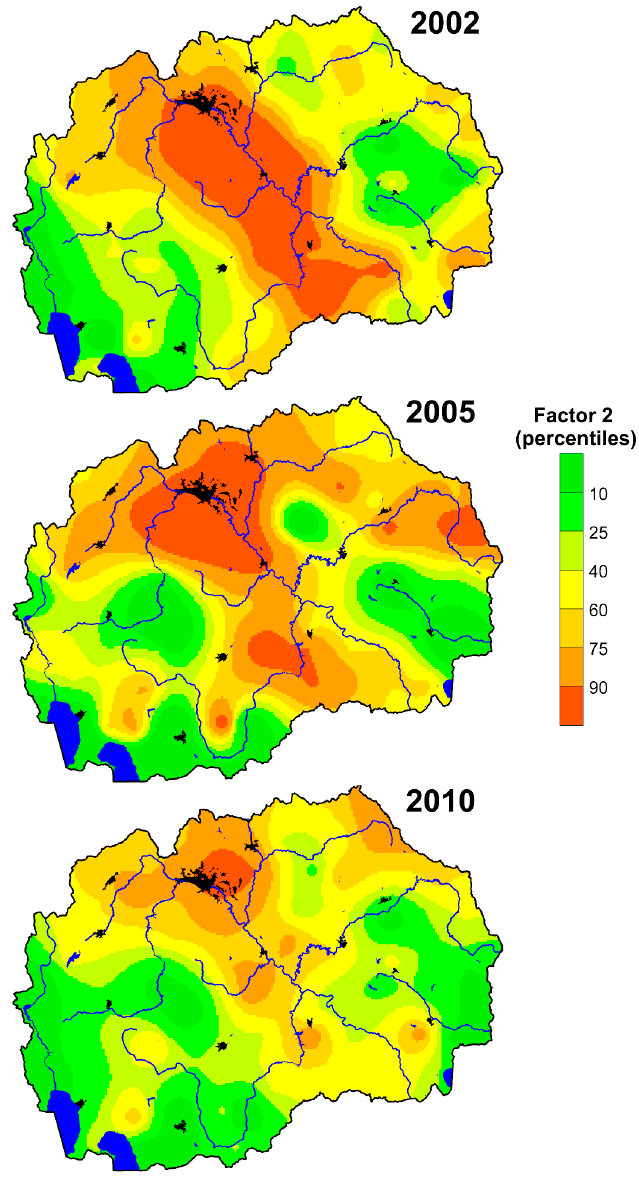
Figure 7. Spatial distribution of F2 factor scores (Cd-Pb-Sb-Zn).